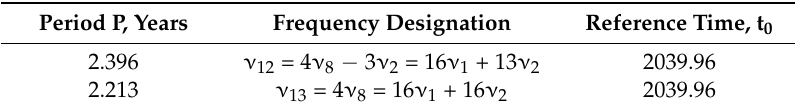
Table 6. Bidecadal tidal components.